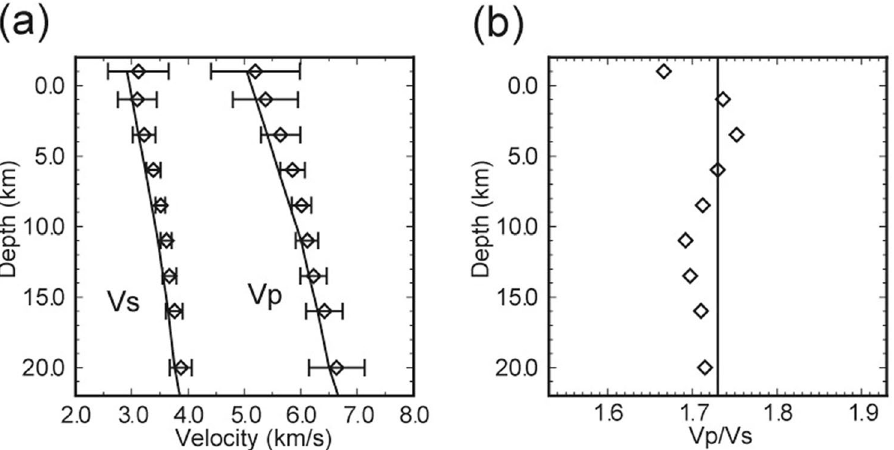
Figure 3. (a) Initial (lines) and final (diamonds) one-dimensional seismic velocity models. Final 1D velocities were calculated from a weighted average using the derivative weight sum (DWS). The standard deviations of the resultant model are plotted as horizontal bars. (b) Initial (line) and final (diamonds) Vp/Vs